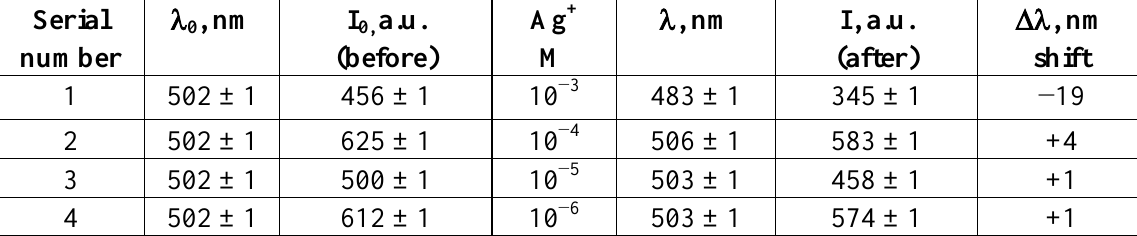
Table 4. The wavelength for the fluorescence maximum (nm) and absorption intensity (a.u.) for the polymer-dye film based on PVC before (  AgClO 4